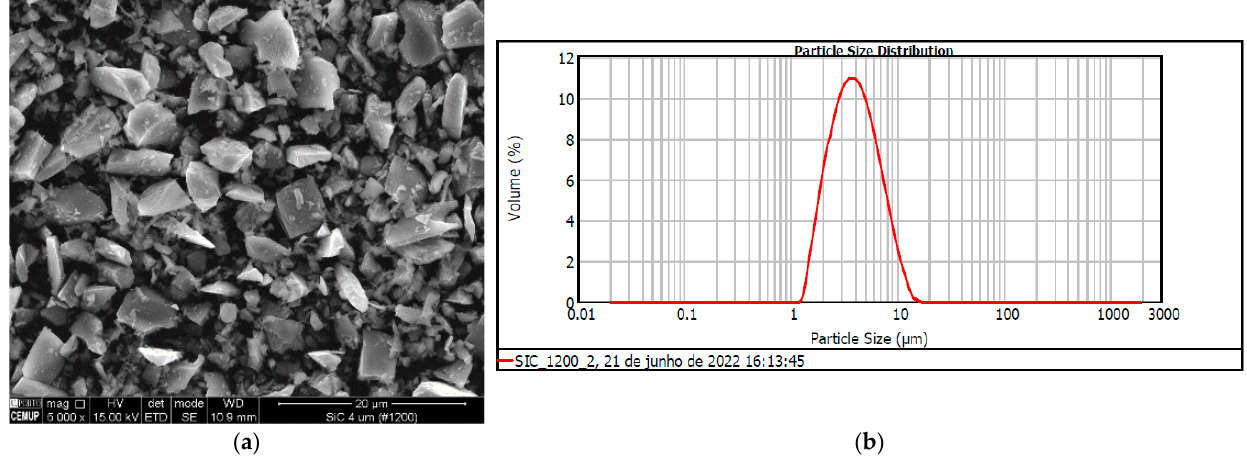
Figure 2. ( a ) SiC abrasive particles aspect, ( b ) distribution of the particle’s